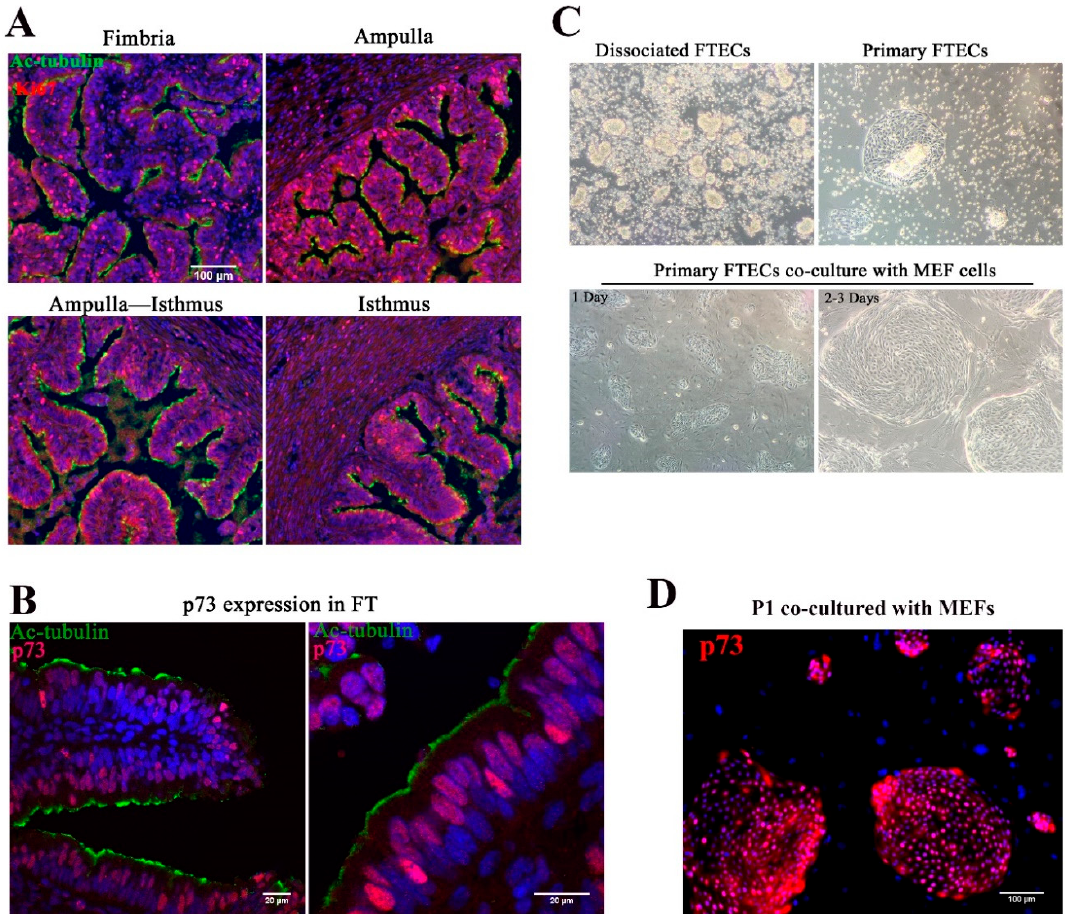
Figure 1. Isolation and characterization of primary fallopian tube epithelium cells (FTECs). ( A ) Immunostaining of porcine fallopian tube epithelium from fimbria to isthmus by anti-acetylated- tubulin (Ac-tubulin) and anti-Ki67 antibodies, counterstained with DAPI. Scale bars: 100 µ m. ( B ) Immunostaining of porcine fallopian tube epithelium by anti-acetylated-tubulin, -p73, and DAPI. p73 was used as basal cell marker for FTECs. Scale bars: 20 µ m. ( C ) FTECs released from the FT after digestion with collagenase type IV and DNase I. Mobile small clumps that exhibited cilia were observed in the medium. These clumps were the source of primary FTECs. The cell clumps attached to the dish after 2 days in the presence of 10% FBS. After reaching confluence, the FTECs were trypsinized and co-cultured with proliferation-incompetent feeder mouse embryo fibroblast (MEF) cells in serum-free expansion medium. The FTECs grew in a colony-like manner, which became bigger during culture and reached confluence in 1 week. ( D ) Primary FTECs co-cultured with MEF cells in basal medium also showed p73-positive colonies. Scale bar: 100 µm.